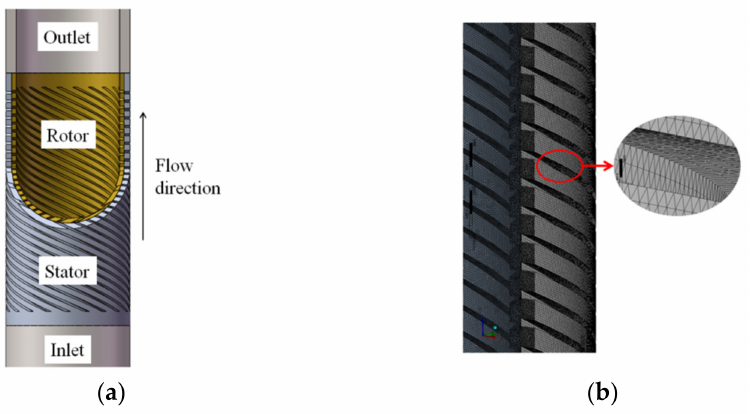
Figure 3. ( a ) Model of stator and rotor fluid domain and ( b ) partial mesh section view.